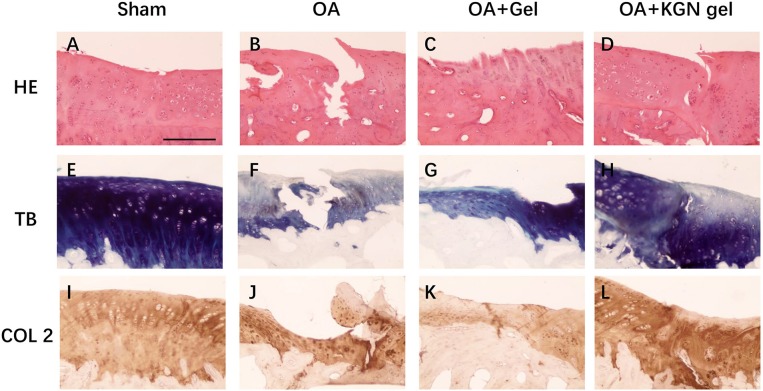
Histological staining of OA knee treated with saline (OA), thermogel (OA + Gel), and KGN thermogel (OA + KGN gel) at 6 weeks after ACLT surgery. (A–D) H&E, (E–H) toluidine blue (TB), and (I–L) immunohistochemistry (IHC) COL-2 staining.